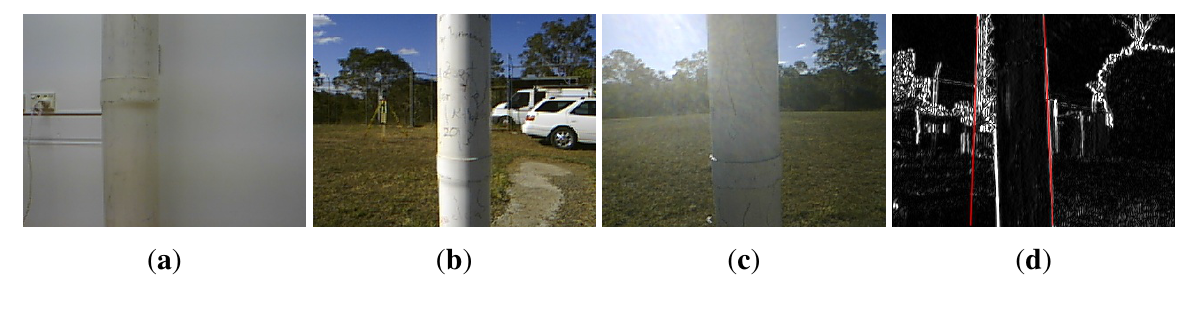
Figure 41. Challenging images for indoor ( a ) and outdoor ( b – d )